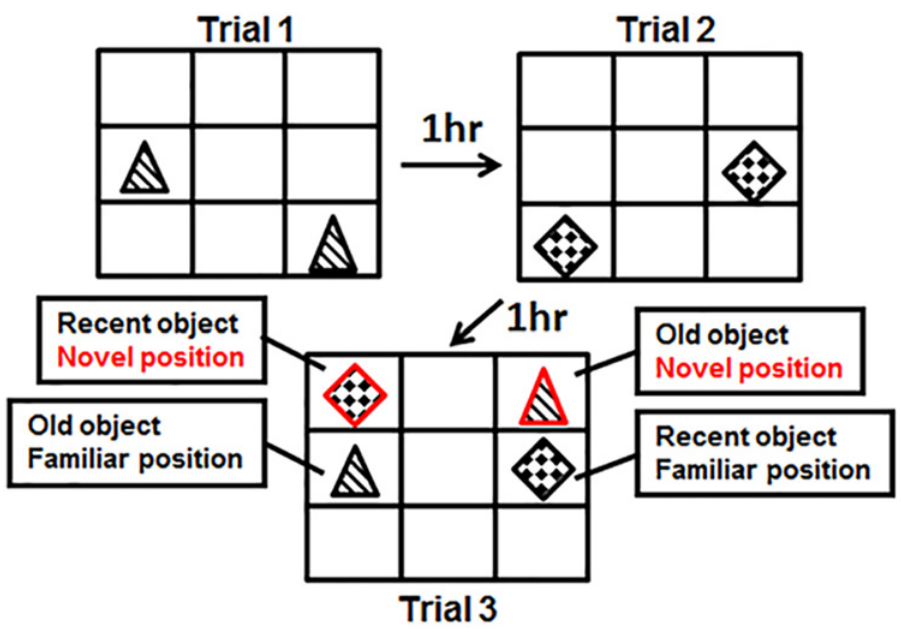
Fig 1. Depiction of the three test trials used in the stOR task. Animals were placed in the chamber with two objects (trial 1). After a 1-hour delay, animals were returned to the chamber with two new objects; after another 1-hour delay animals were returned to the chamber containing the four previously encountered objects. One object from trial 1 and one object from trial 2 were placed in new positions while the other objects remained in their original